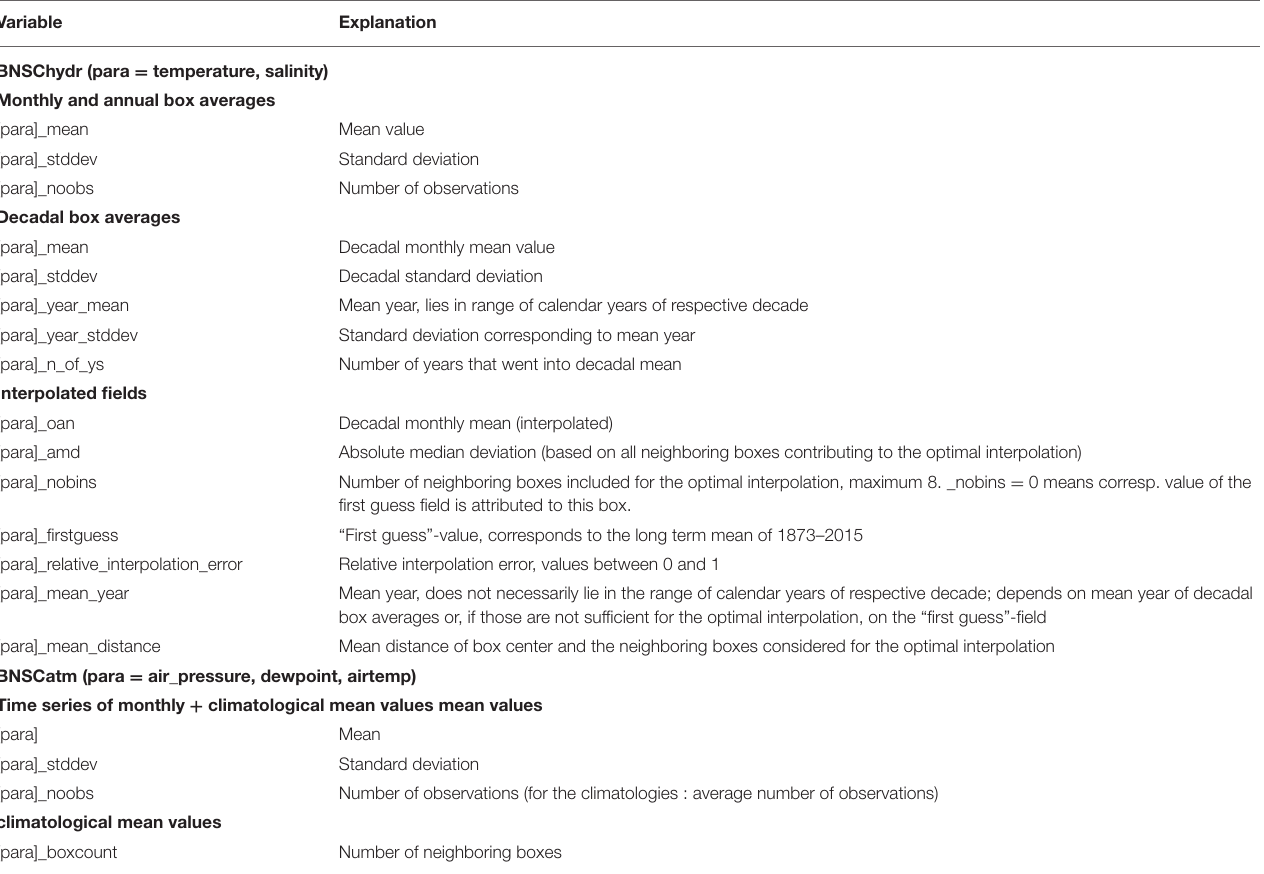
TABLE 6 | Overview, variables of the data